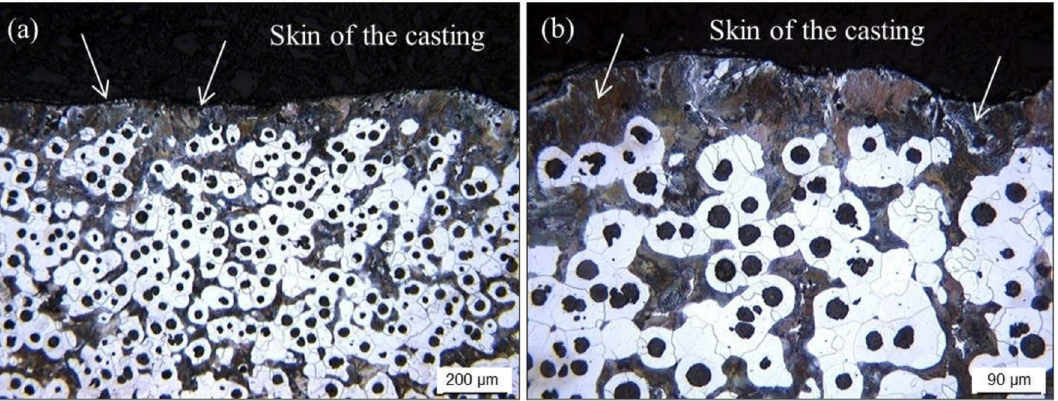
Figure 56. Metallographic cross sections of a ductile iron casting with a continuous pearlitic rim and a mainly ferritic matrix ( a ). A detailed view is shown in ( b